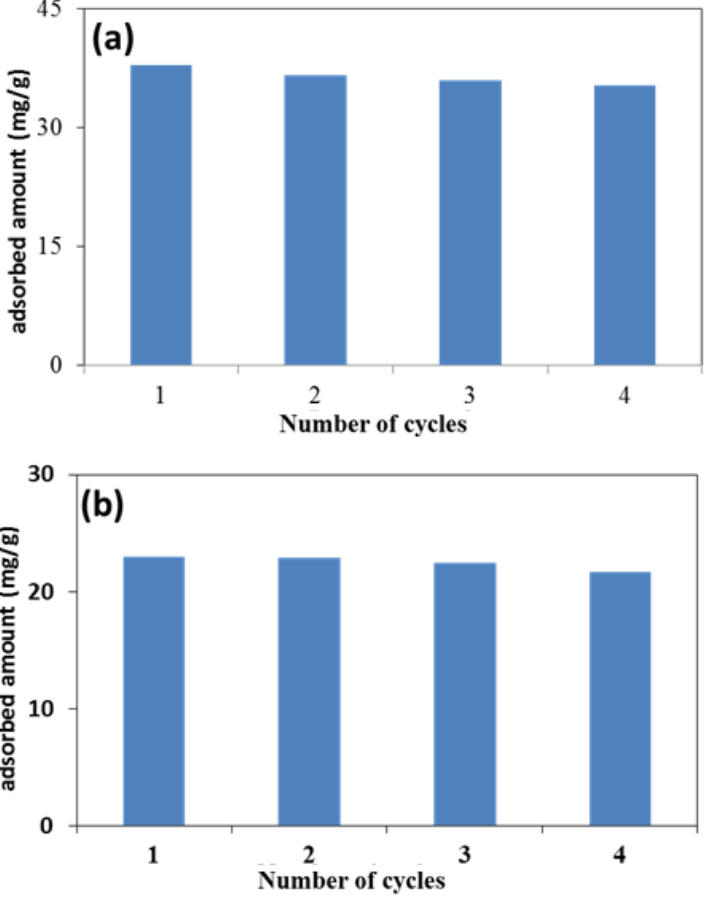
Figure 6. Desorption efficiency plots of ( a ) MG in 0.1 M HCl, ( b ) EV in ethanol solvent up to 4 successive cycles.